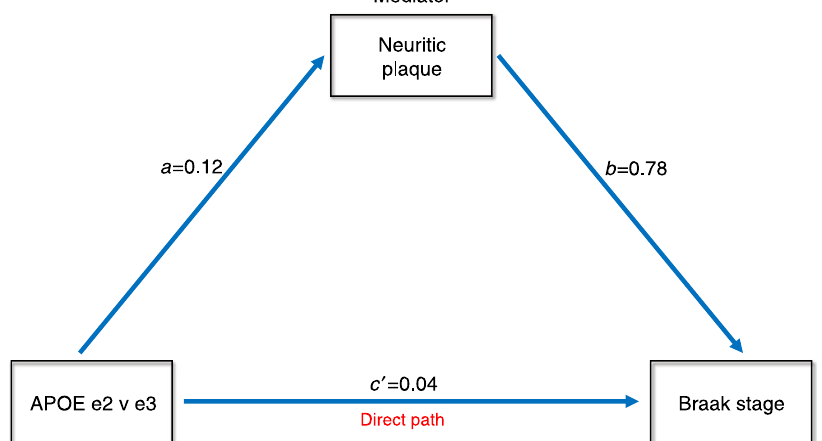
Fig. 2 Mediation analysis of APOE e2 versus e3 showing both direct and indirect effects (via neuritic plaques) on Braak stage. Values represent beta weights after adjustment.